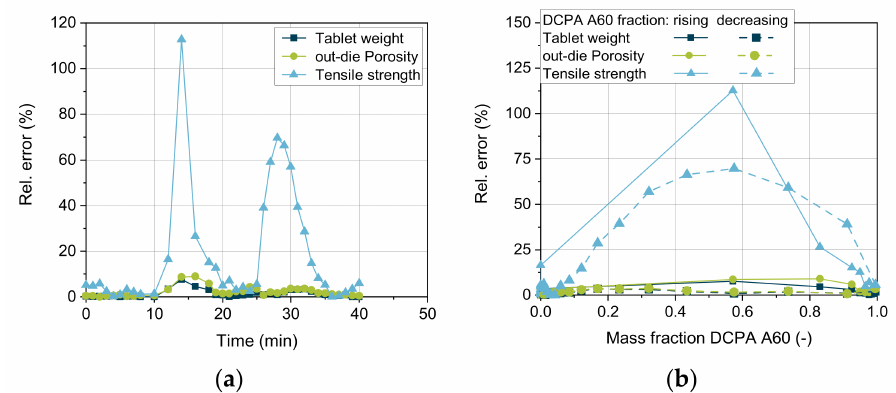
Figure 16. Relative error of the simulative data compared to experimentally determined values for the ( a ) tablet weight, out-die porosity, and tensile strength over time and ( b ) the mass fraction of DCPA